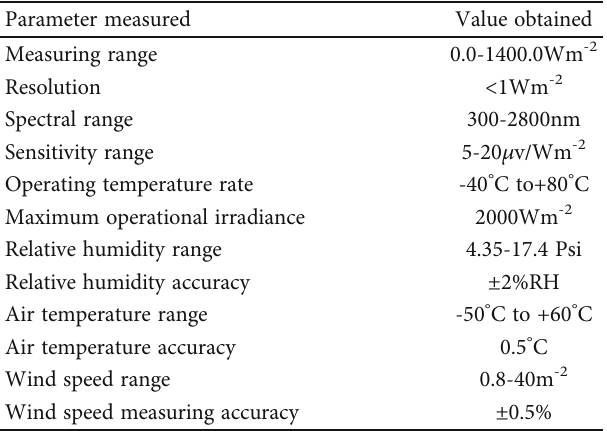
Table 3: Meteorological data for